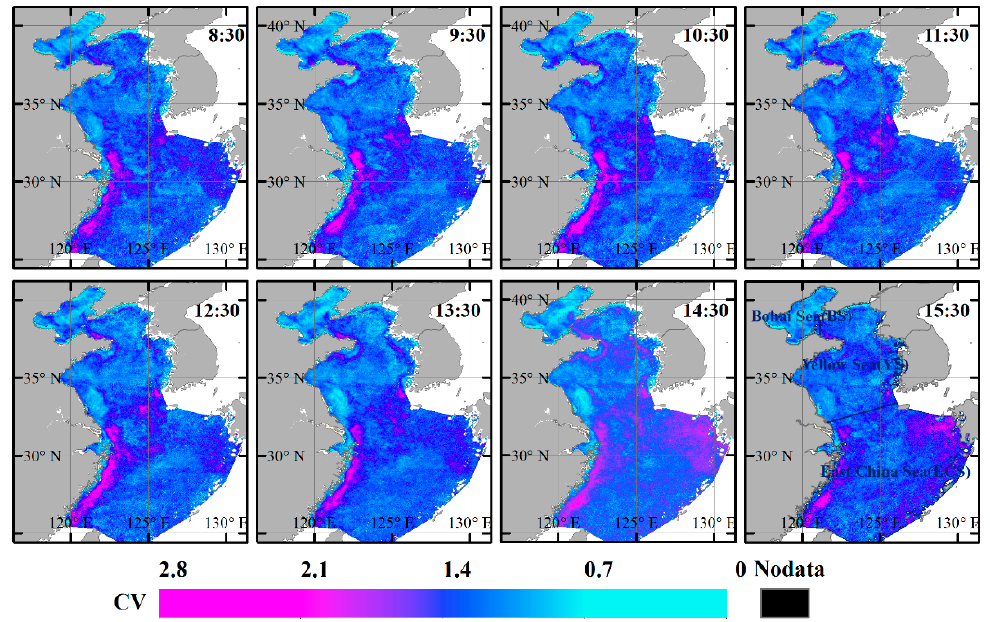
Figure 8. CV in hourly TSS levels in Chinese seas from GOCI observations from 2013 to 2017.